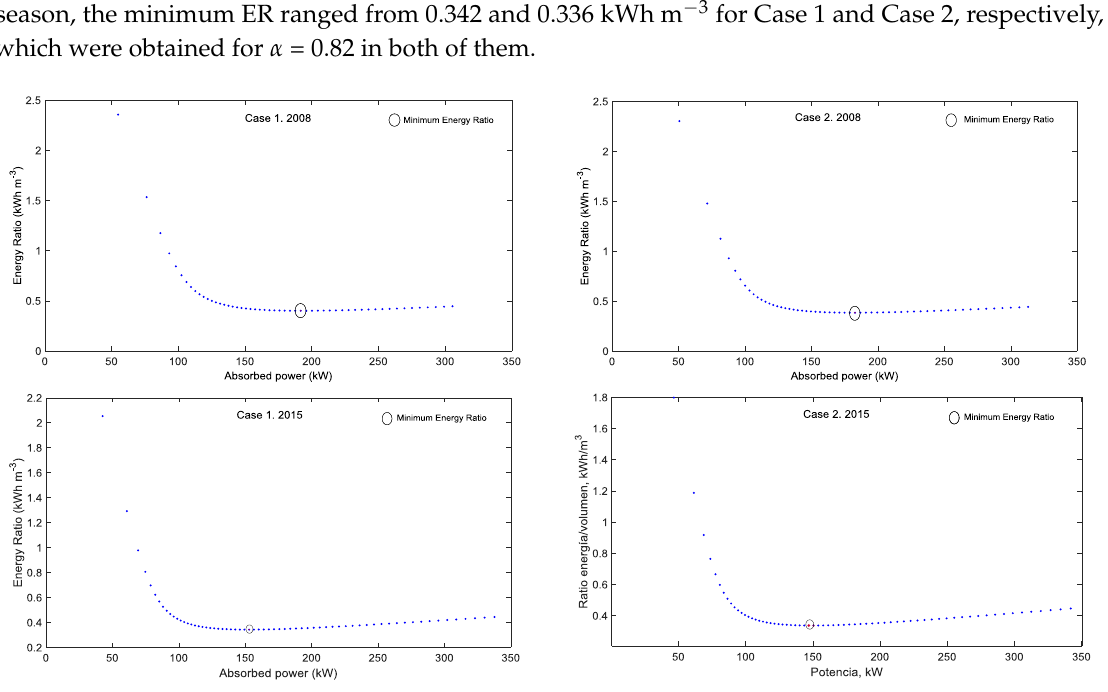
Figure 8. Pump efficiency (%) depending on the variable speed ratio in WUA A.